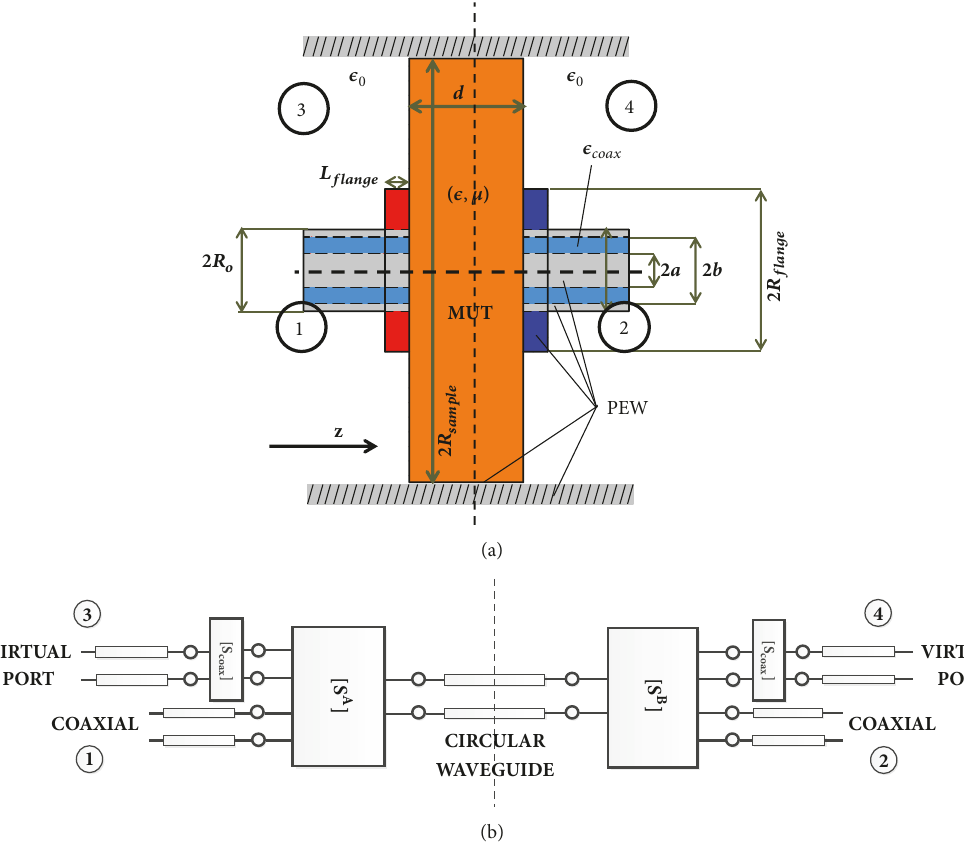
Figure 14: (a) Dimensions defining the model B (with revolution symmetry) taking the finite flanges into account. (b) Block diagram of the analysis by mode-matching, showing the symmetry plane.